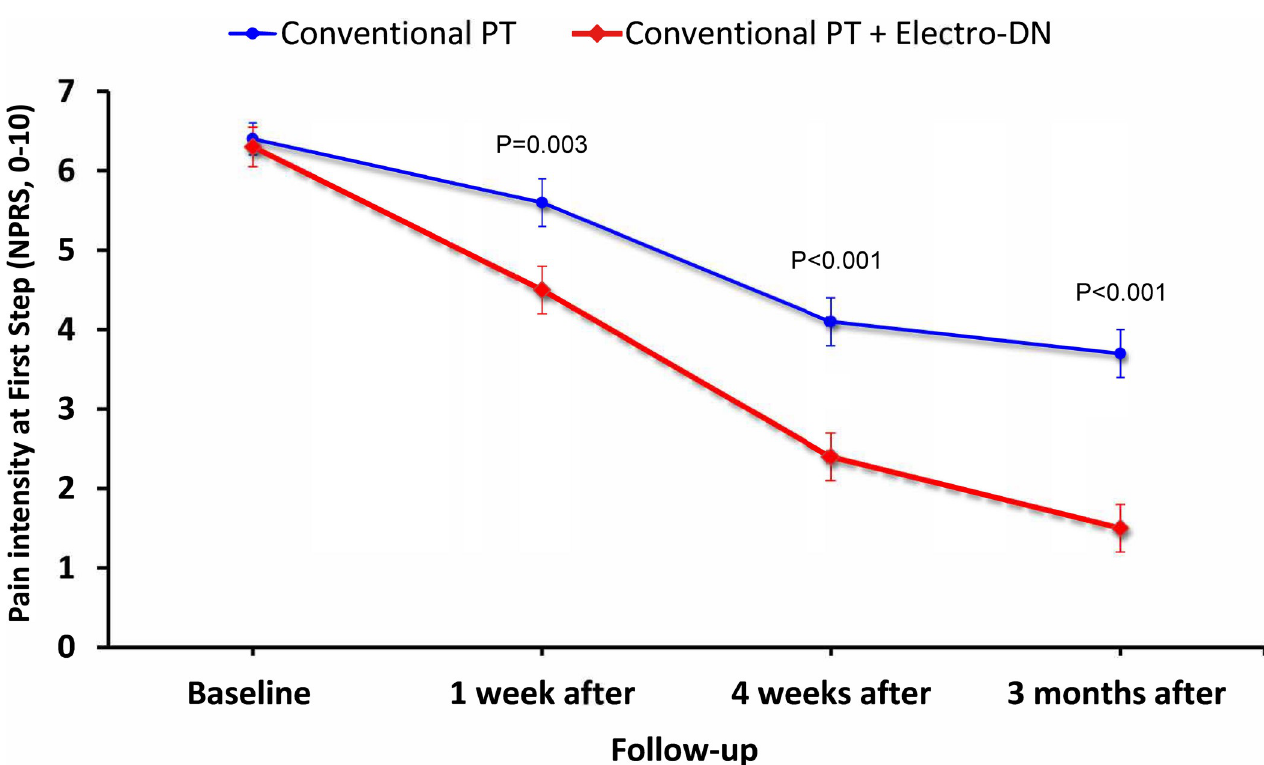
Fig 3. Evolution of first step pain intensity (NPRS) throughout the course of the study stratified by randomized treatment assignment. Data are means (standard error).